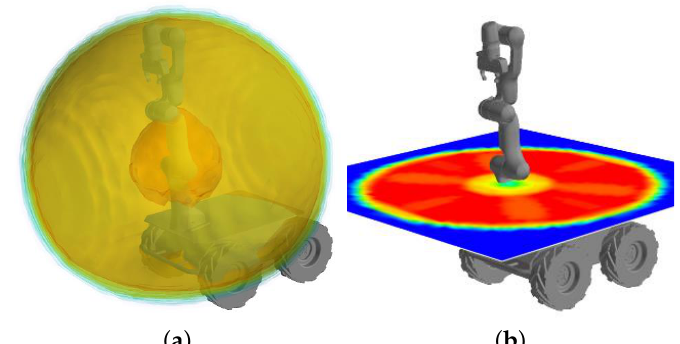
Figure 6. Visualization of reachability shown in OPENRAVE [31]. ( a ) The contour of reachability of the end-effector; ( b ) the reachability cut by a horizontal plane at the base of the manipulator is colored (right, red: high, blue: